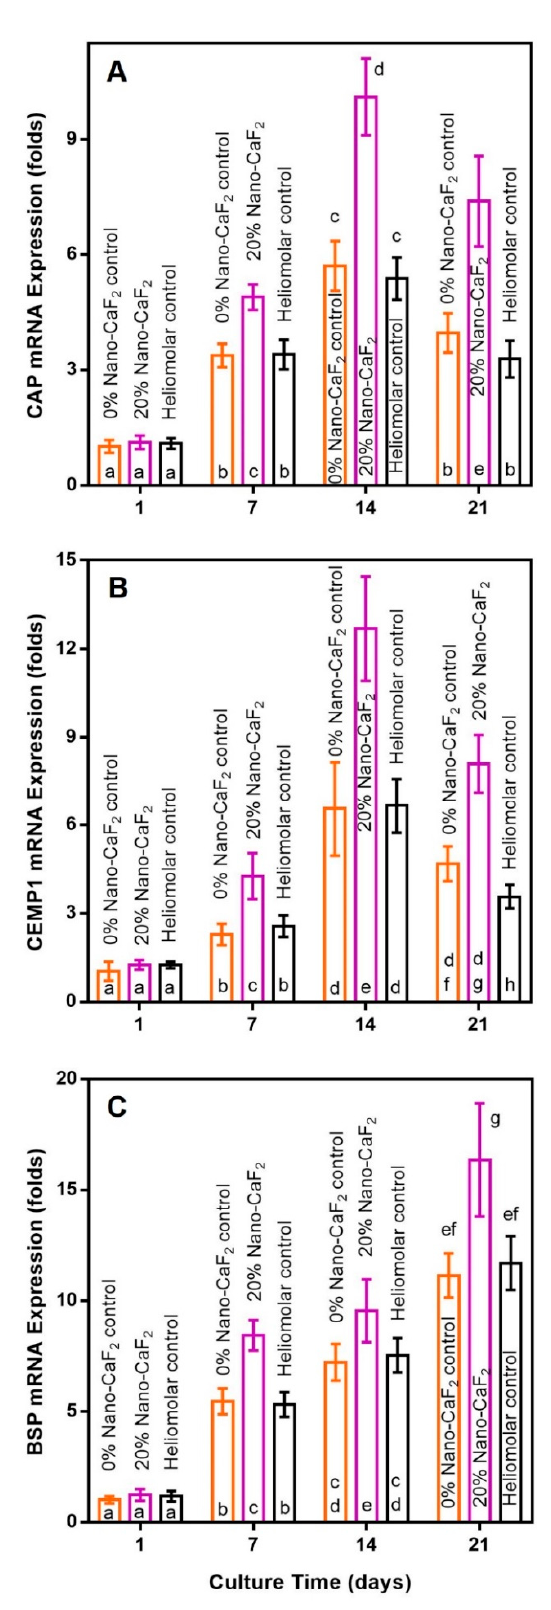
Figure 6. The expression of cementogenic genes of hPDLSCs growing on composites. All genes were promoted by the incorporation of 20% Nano-CaF 2 in the composite at 14 days (CAP ( A ) and CEMP1 ( B ) genes) and 21 days (BSP gene ( C ). Values with dissimilar letters such as a and b are significantly different ( p < 0.05, mean ± SD; n = 6) .